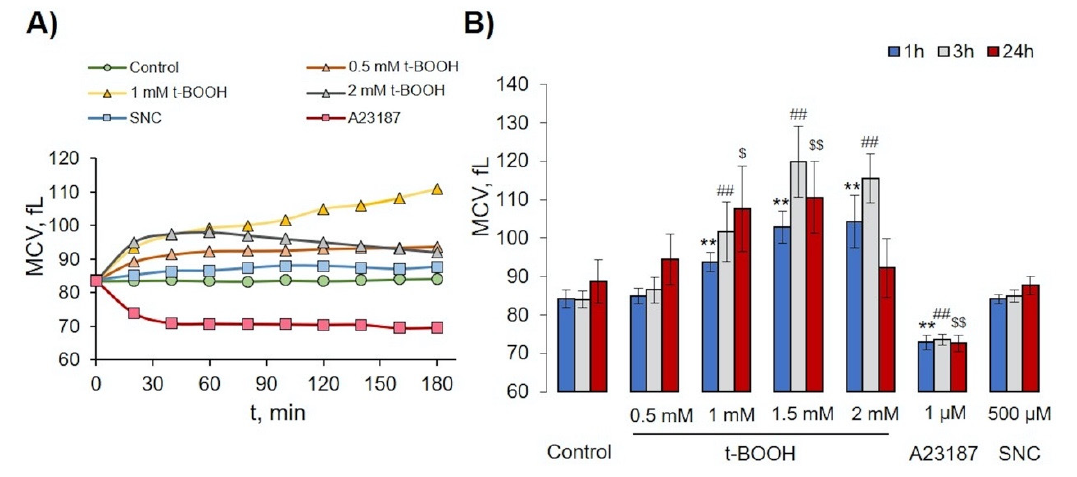
Figure 3. E ff ects of t-BOOH, A23187, and SNC on RBC volume changes. RBCs (0.5 × 10 9 cells / mL) were incubated with indicated concentration of t-BOOH, A23187, and SNC for indicated times and were analyzed by hematological analyzer. ( A ) Representative histogram of mean cell volume (MCV) changes for one donor for 3 h; symbols indicate time of analysis. ( B ) Quantitative data from 10 independent experiments (10 donors). Data are presented as mean ± SD ( n = 10), one-way ANOVA, Levene’s test < 0.05, and Tamhane T2 post hoc. ** p < 0.001 compared to 1h control; ##, p < 0.001 compared to 3 h control; $, p < 0.05, $$, p < 0.001 compared to 24 h control.